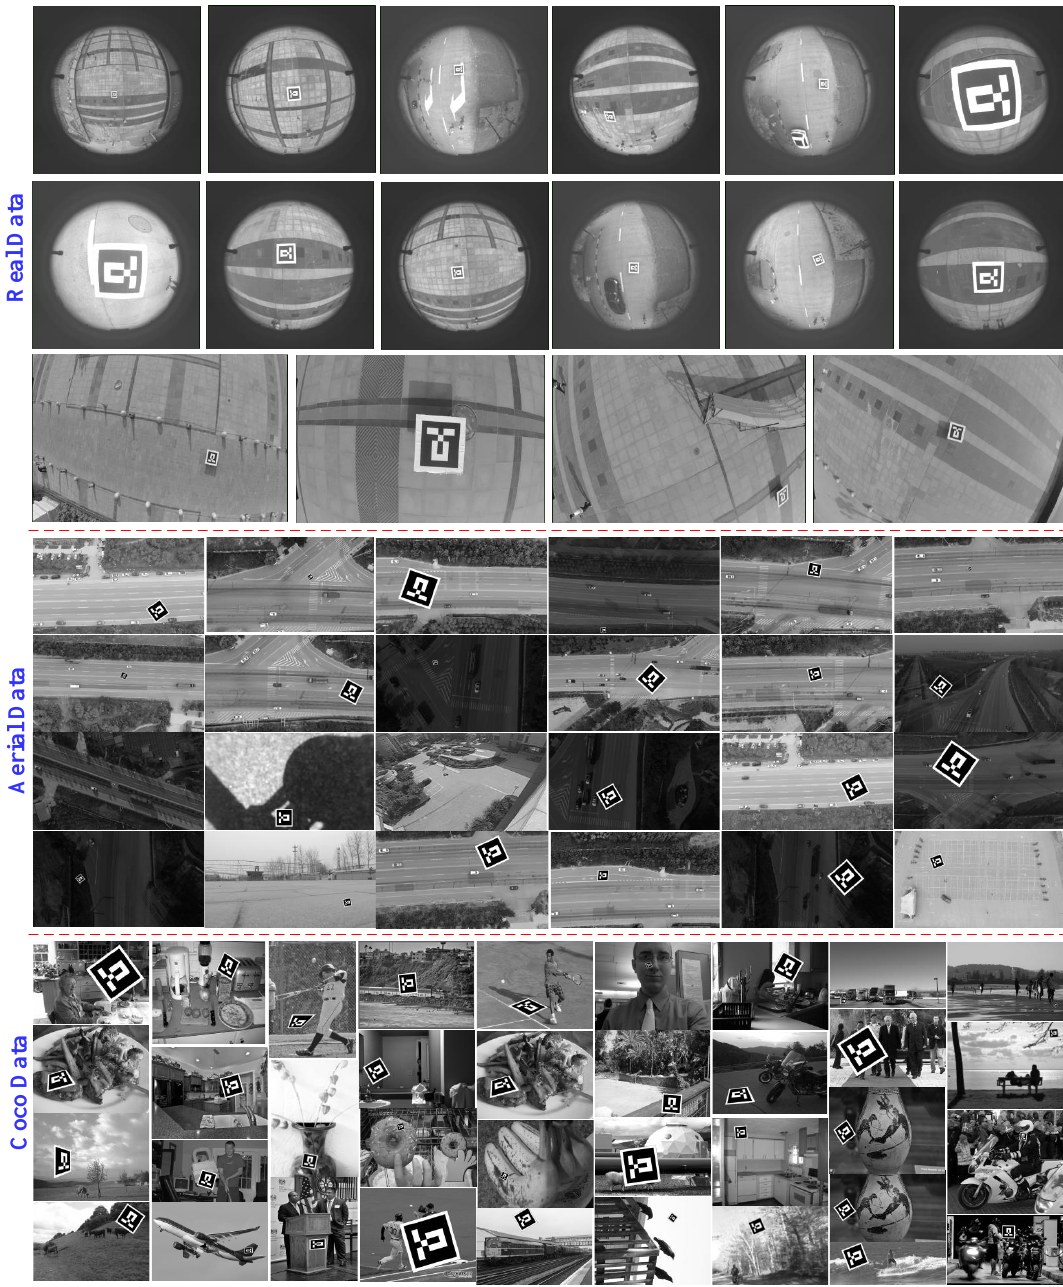
Figure 11. Some images in our training dataset, including the real captured images and the composite images of complex scenes. Among them, the original images include near-infrared fisheye images captured by the Point Grey camera and grayscale images; the composite images include the Coco Test 2017 dataset and our own complex aerial